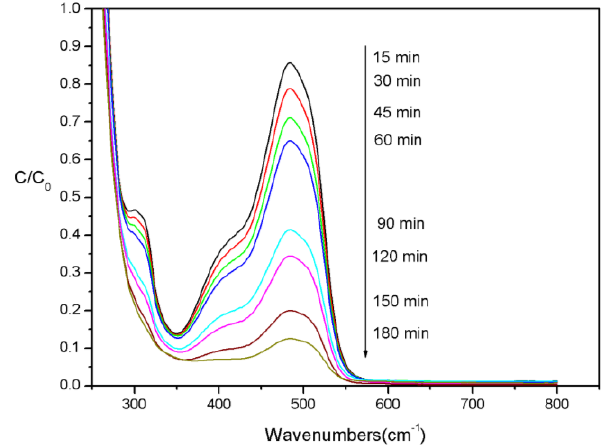
O ) = 4.85 × 10 −2 mol/L, 25 °C]. 2 2